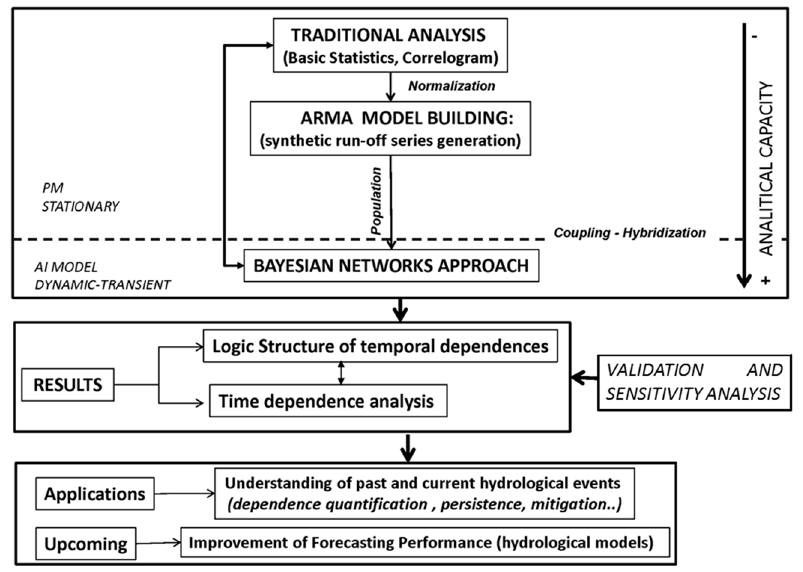
Figure 2. General methodology.